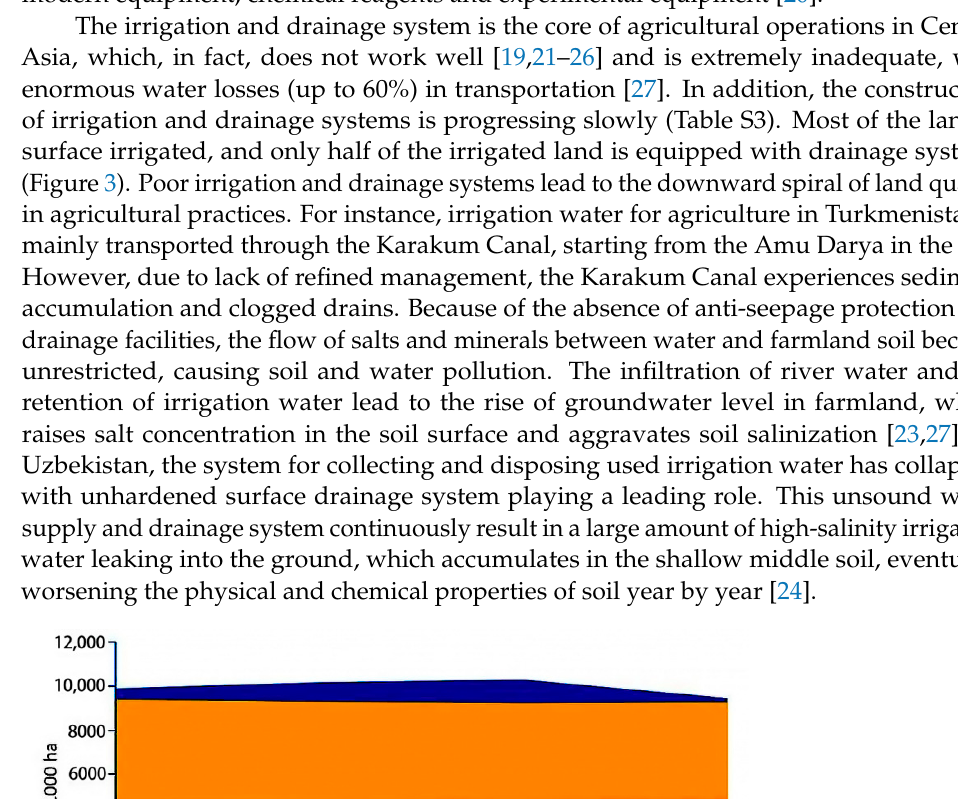
Table 5. Comparison between monthly per capita agricultural income and national income in Central Asia in 2020. (Unit: dollar).